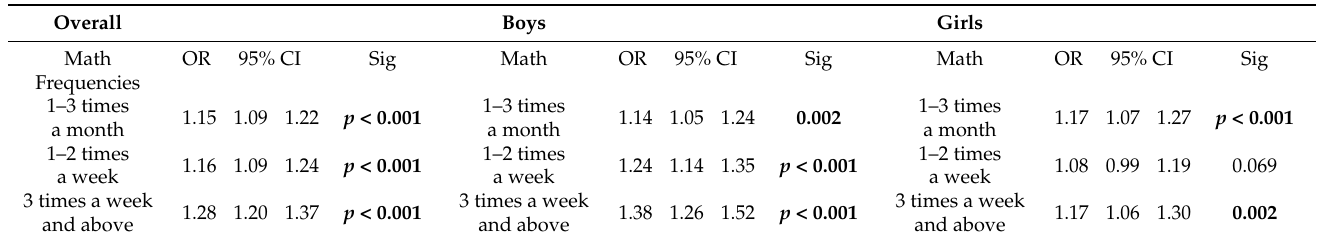
Table 4. Odds ratio and 95% CI for academic performance concerning the sports participation (Math).